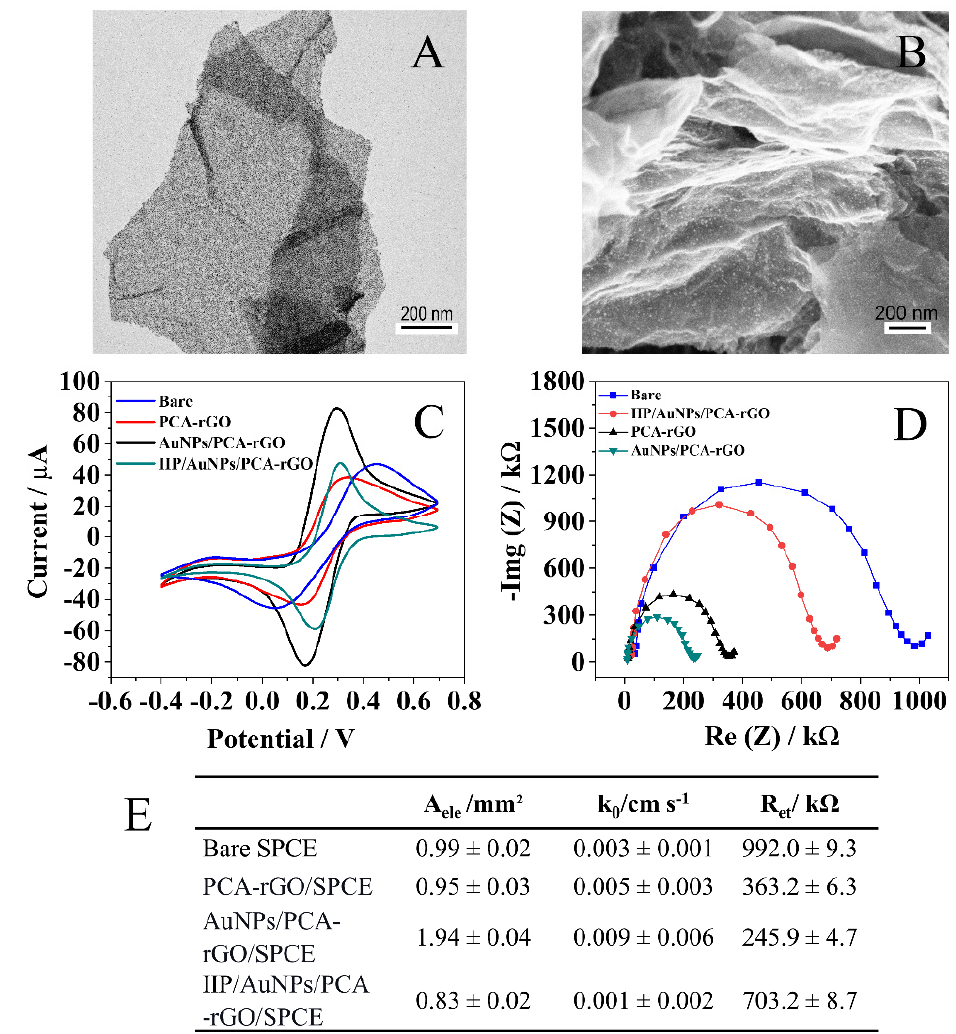
Figure 1. ( A ) TEM micrograph of the AuNPs/PCA ‐ rGO and ( B ) SEM image of the AuNPs/PCA ‐ rGO/SPCEs (127.92 KX). ( C ) CV scans collected at 50 mV s − 1 and ( D ) EIS spectra of the SPCEs, PCA ‐ rGO/SPCEs, AuNPs/PCA ‐ rGO/SPCEs, and IIP/AuNPs/PCA ‐ rGO/SPCEs, in 0.01 M PBS (pH 7.4), 5 mM in Fe[(CN) 6 ] 3 − /4 − and 0.1 M in KCl. ( E ) Electroactive surface area (A ele ), apparent heterogeneous electron transfer constant (K 0 ), and electron transfer resistance (R et ) of the SPCEs, PCA-rGO/SPCEs, AuNPs/PCA-rGO/SPCEs, and